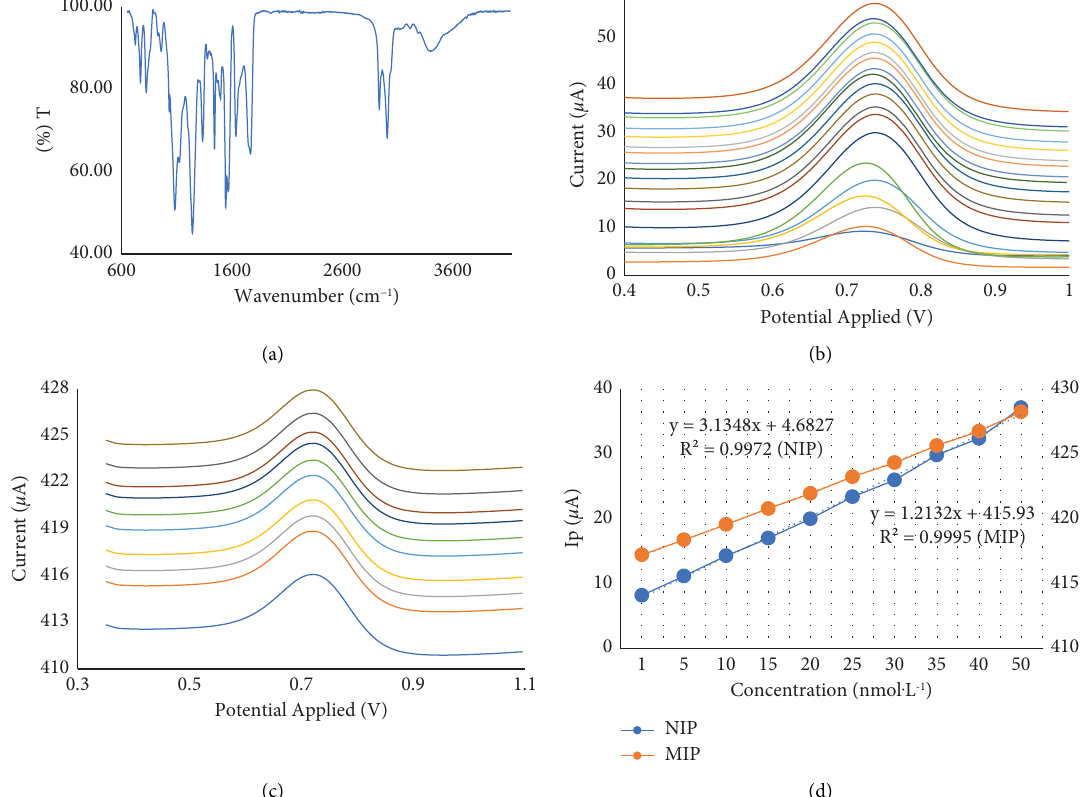
Figure 4: (a) Te FTIR spectrum of the MIP flm. (b) Te voltammograms of DPV after analyzing histamine in various